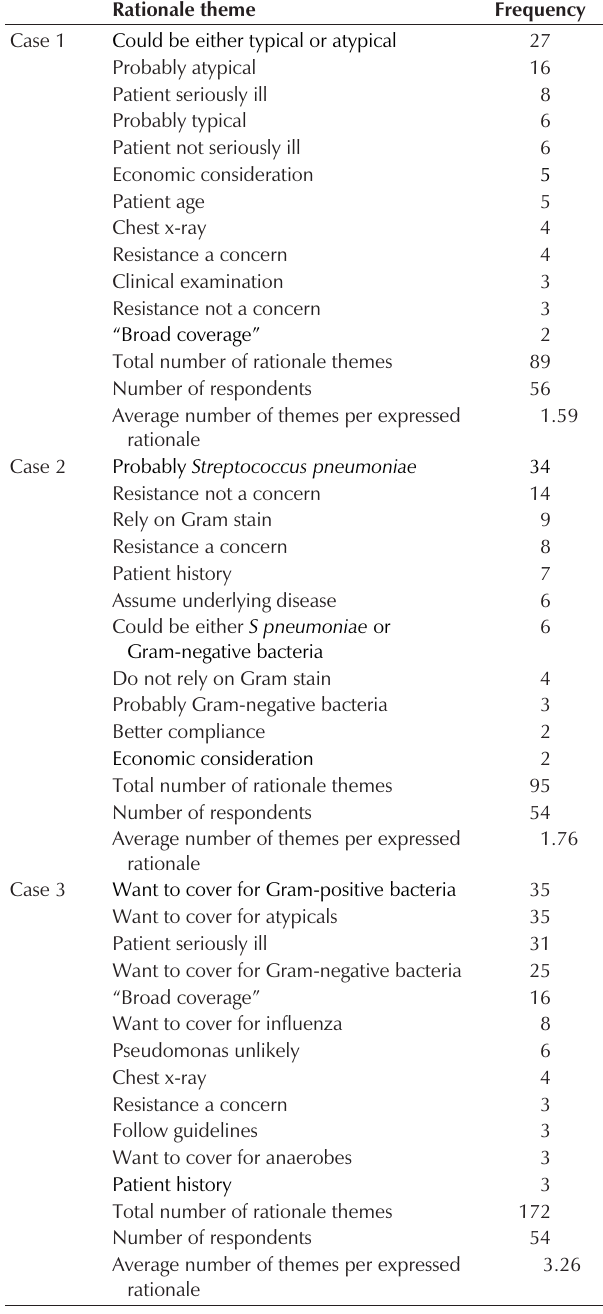
Rationale themes identified in open-ended questionnaires for a survey of Canadian infectious disease